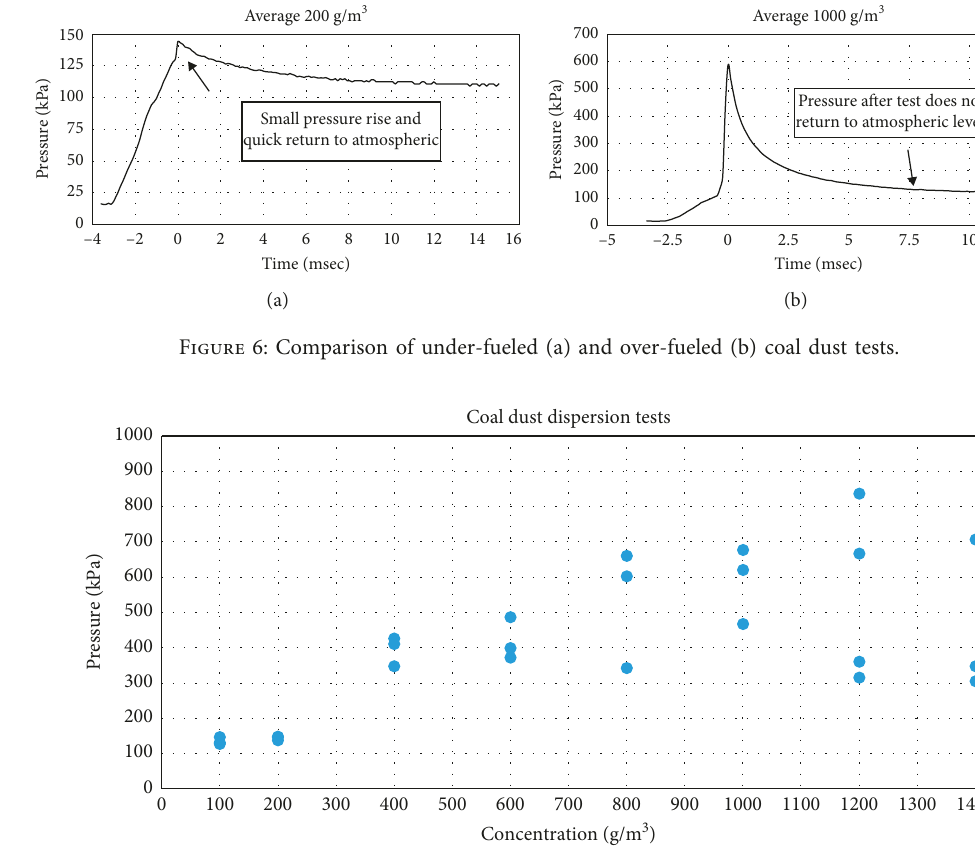
Figure 7: Coal dust explosibility tests (adapted from